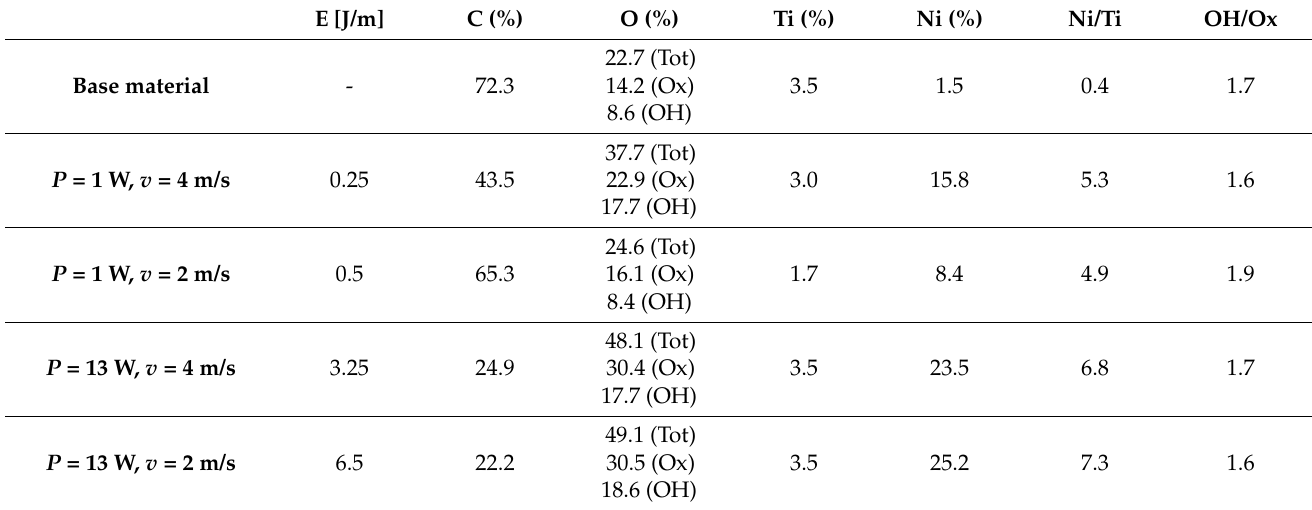
Table 4. Atomic percentage for C, O, Ti and Ni elements and Ni/Ti and OH/Ox ratio. E [J/m] C (%) O